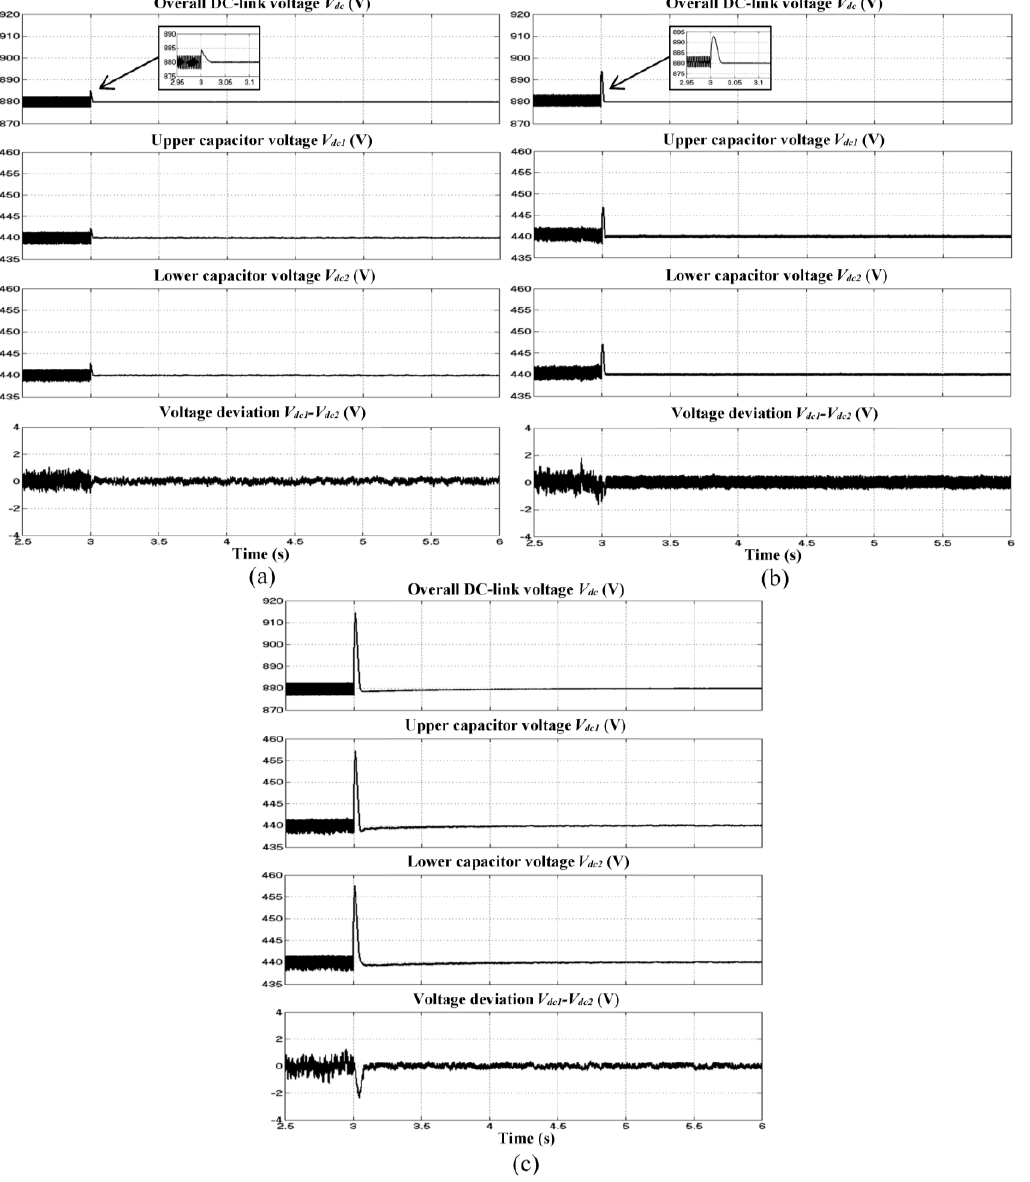
Figure 8. Simulation results of SAPF which include overall DC-link voltage 𝑉 𝑑𝑐 , splitting DC-link capacitor voltages ( 𝑉 𝑑𝑐1 and 𝑉 𝑑𝑐2 ) and neutral-point voltage deviation ( 𝑉 𝑑𝑐1 − 𝑉 𝑑𝑐2 ) for dynamic-state condition of capacitive to inductive load obtained using ( a ) the proposed algorithm with IED control; and ( b ) the conventional algorithm with FLC and ( c ) PI techniques.